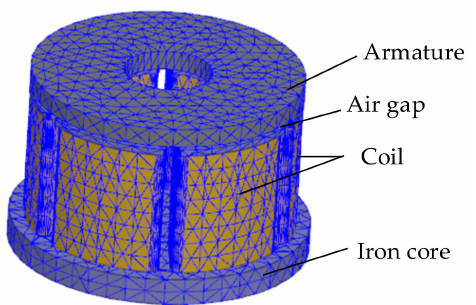
Figure 7. Three-dimensional finite element model of the solenoid valve.